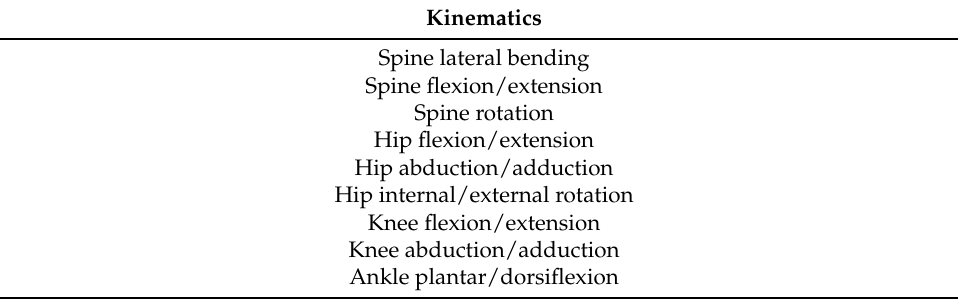
Table 2. Timeseries used as input in